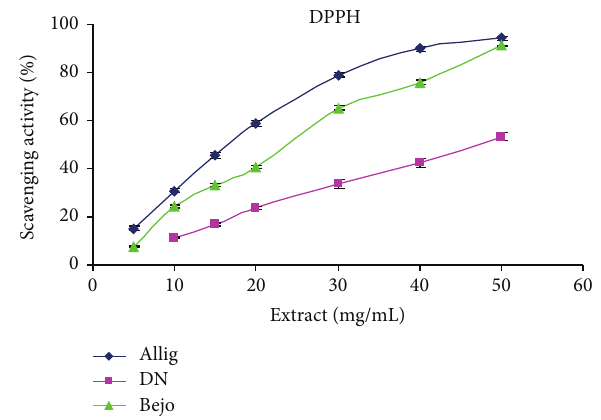
Figure 1: Effect of different concentrations on DPPH scavenging activity in different date extracts: Allig, Bejo and Deglet Nour (DN). Values are means of three replications ±